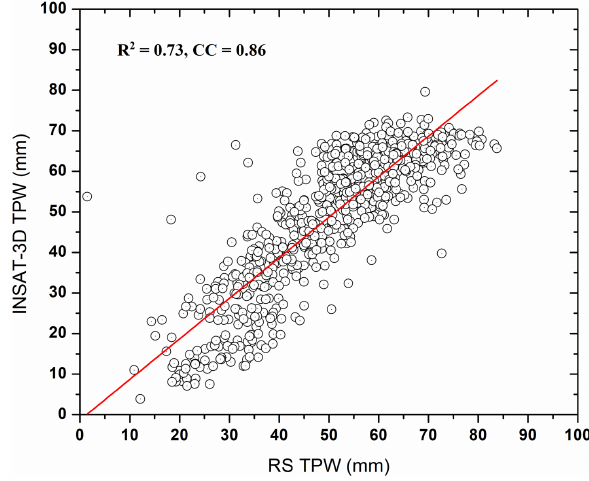
Figure 3. Comparison of INSAT-3D-derived TPW with RS- observed TPW from May to September